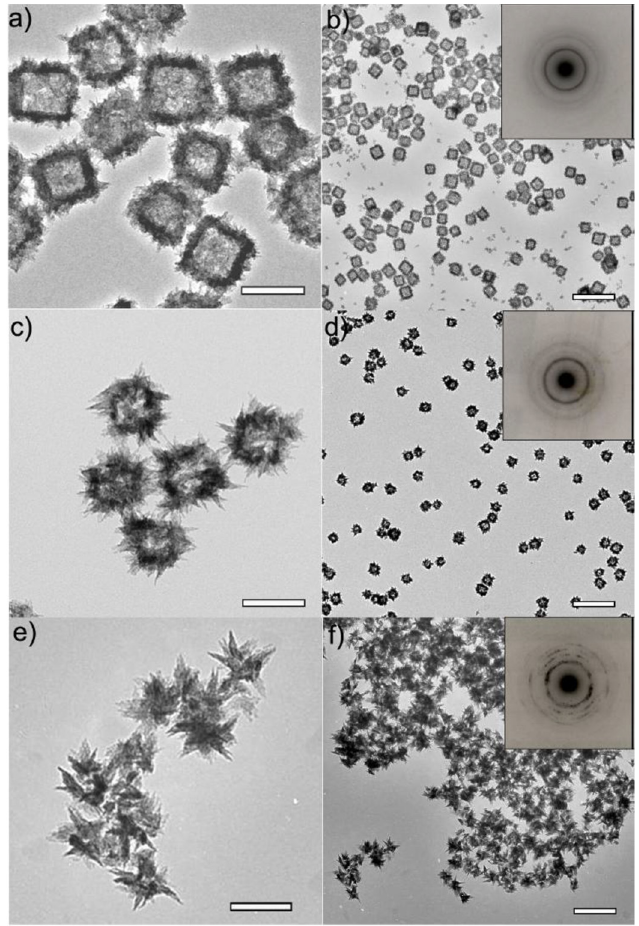
Figure 11. TEM images of CuO nanoparticles exhibiting the shape of hollow cubes ( a , b ), hollow urchins ( c , d ) and urchins ( e , f ). The insets for images ( b ), ( d ) and ( f ) show the corresponding SAED (Selected Area Electron Diffraction) patterns of single particles. Bars mean: 100 nm ( a , c ); 200 nm ( e ); 500 nm ( b , d , f ). Reproduced from [211] with permission from the Royal Society of Chemistry.